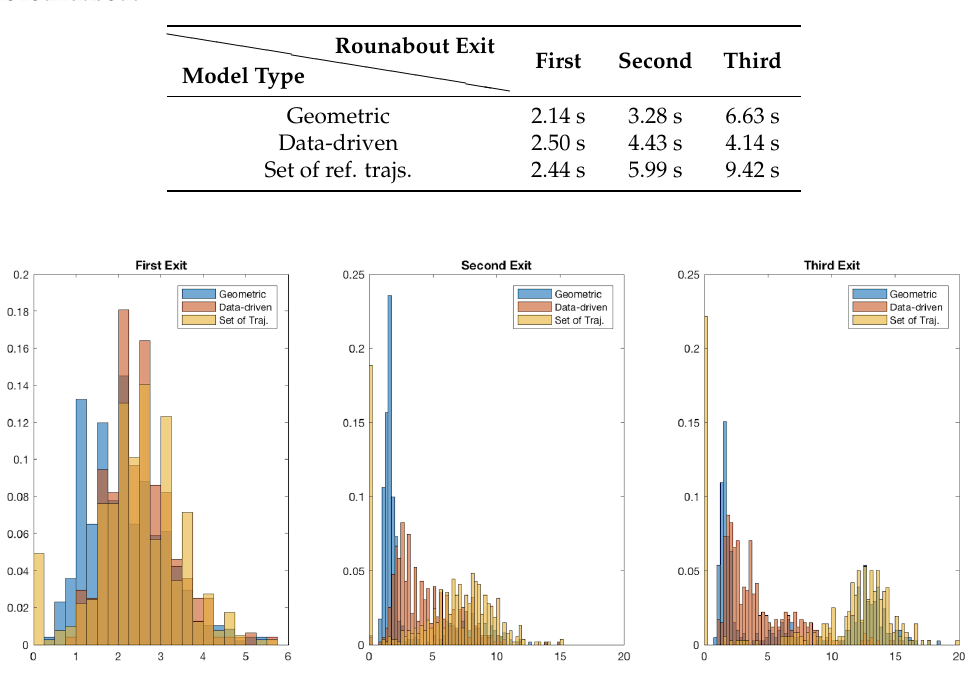
Figure 6. Exit-direction classification. Normalised histograms for time since convergence: ( a ) first exit; ( b ) second exit; and ( c ) third exit. Note that the bin-size used for all the histograms is uniform, but the axes have been left non-uniform for clarity.